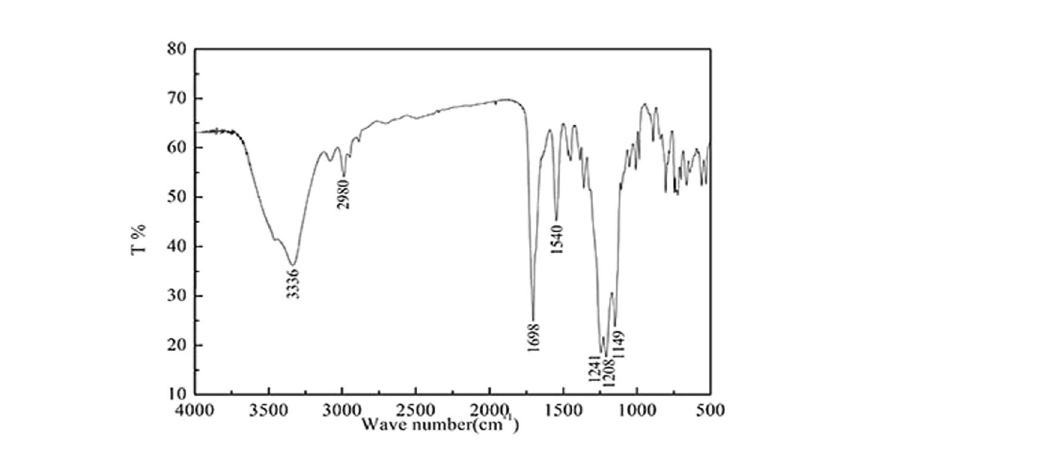
Figure 1. The 1 HNMR spectrum of the novel fluorocarbon surfactant.